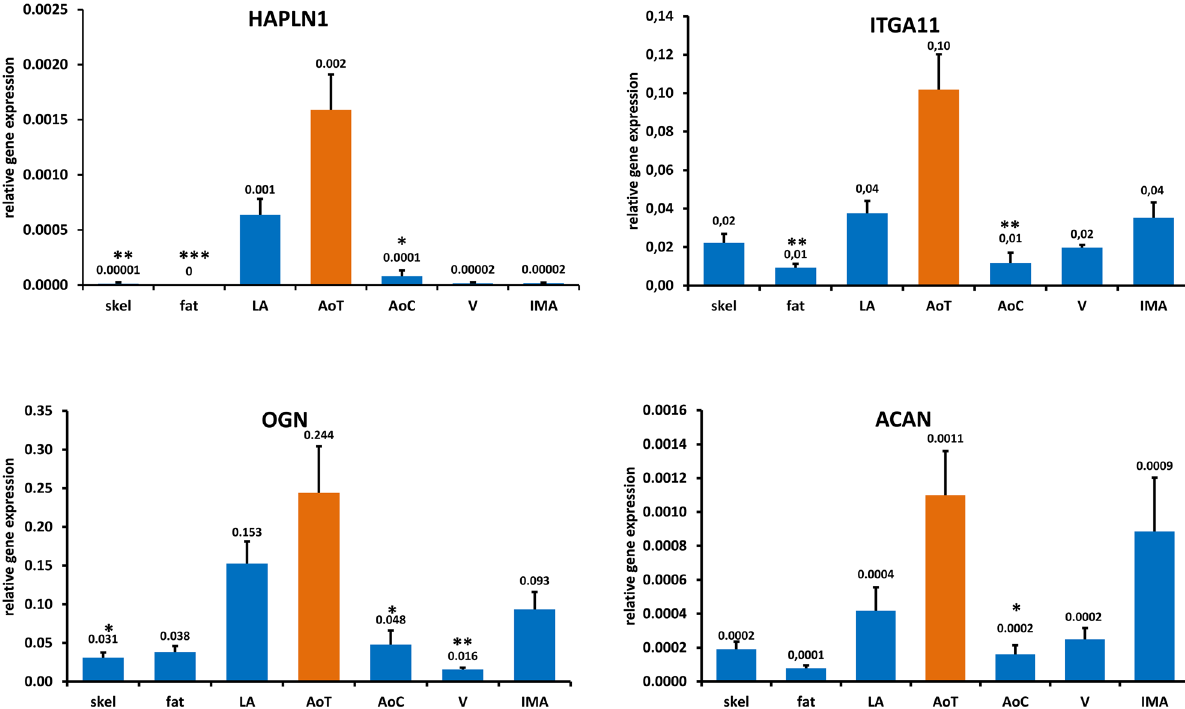
Figure 2. Gene expression in different surgical biopsies. Skel: skeletal muscle (n = 5), fat: subcutaneous fat (n = 5), LA: left atrium (n = 5), AoT: aorta from type A dissection (n = 6), AoC: aorta from coronary artery bypass graft (n = 6), V: vena saphena magna (n = 5), IMA: arteria mammaria interna (n = 5). Values represent means ± SEM. * p < 0.05, ** p < 0.01, *** p < 0.001 compared to aortic tissue from type A dissection. Significance of difference was tested with one-way ANOVA